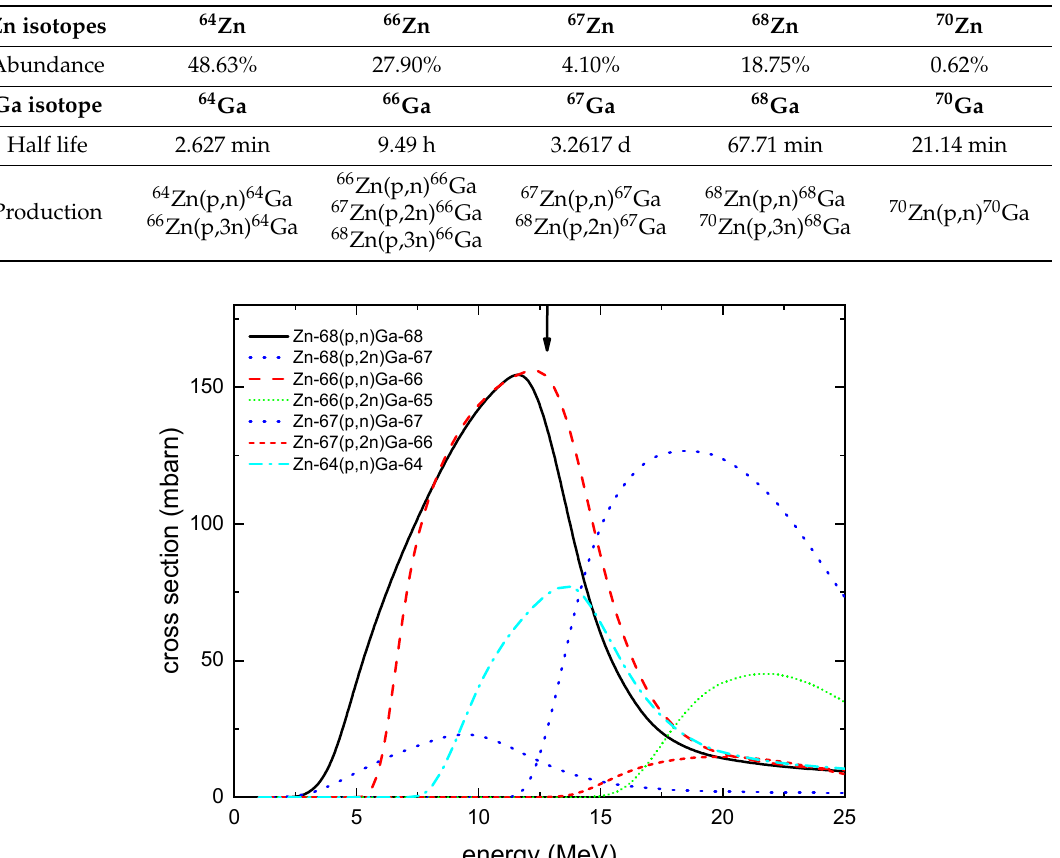
Figure 2. Main cross sections for the production of gallium isotopes from zinc, with the zinc isotopes scaled for natural abundance (see Table 1). The entrance energy of the proton beam in our production is marked with an arrow. Data from [11].